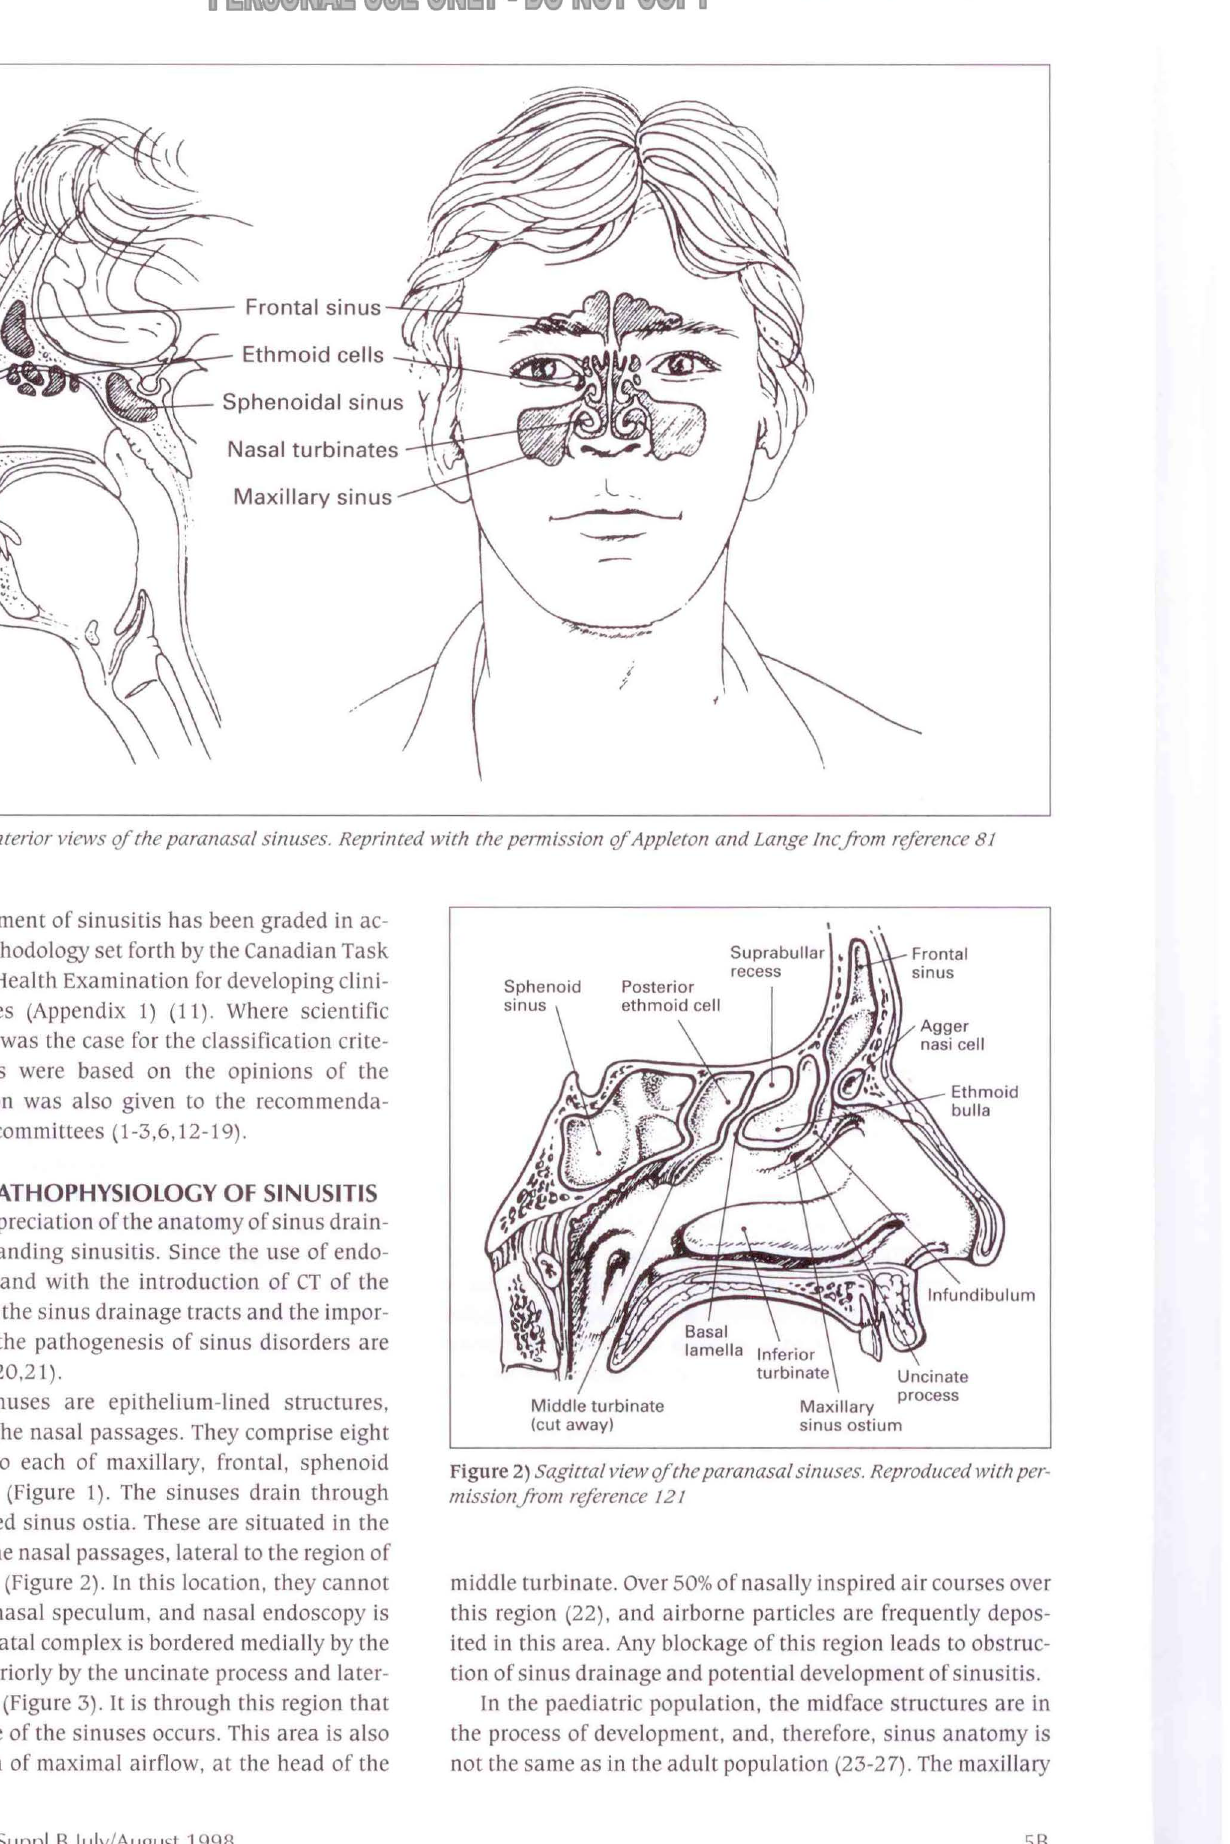
Figure 2) Sagittal view qf the paranasal sinuses. Reproduced with per mission.from reference